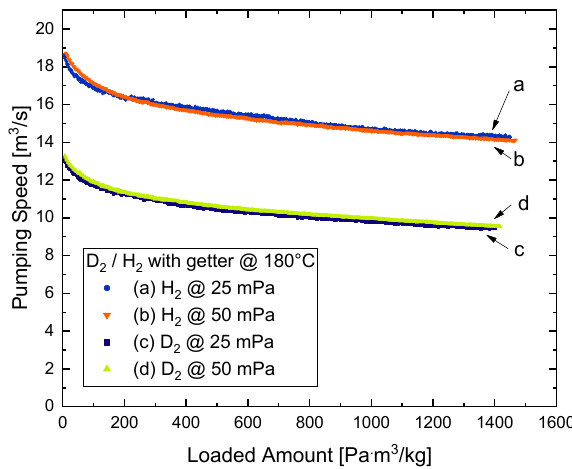
Figure 14. Isotope effect on the pumping speed for H 2 and D 2 .